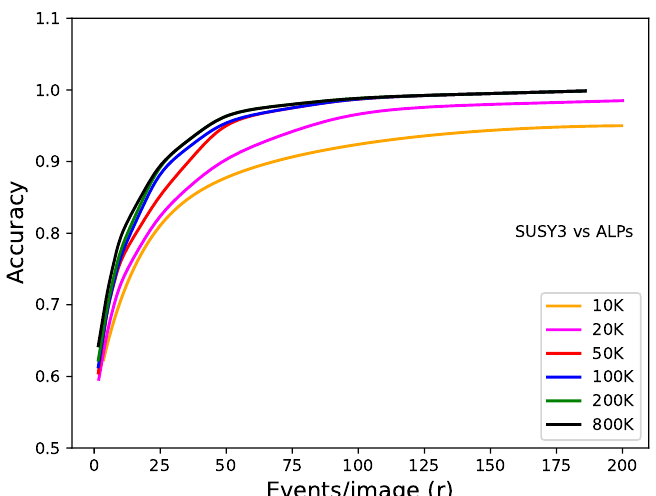
Figure 8: Accuracy versus number of events per image, with varying total number of events for SUSY3 versus ALP. We use fully-connected NNs with two hidden layers for different data sample size. The monojet data set is considered for this